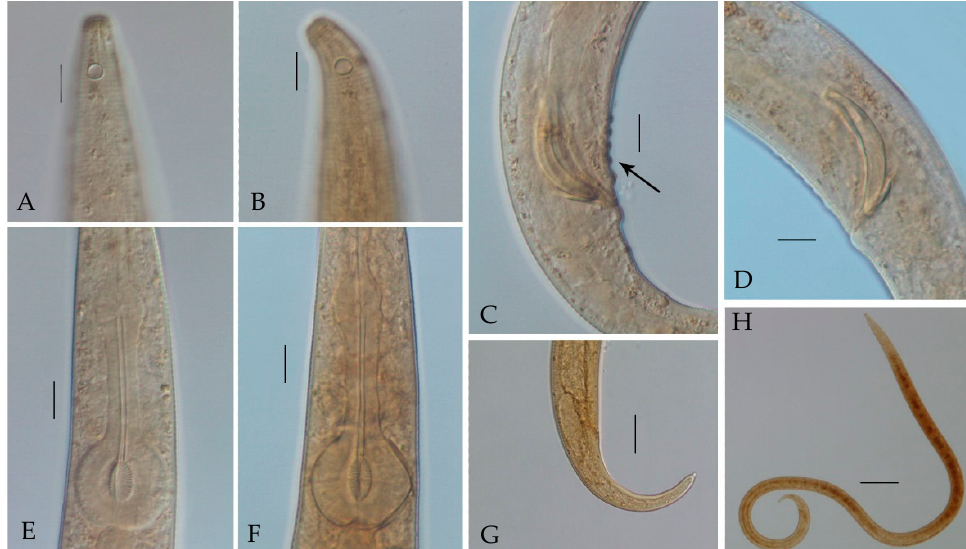
Figure 2. Haliplectus major sp. nov. ( A ) lateral view of male head end showing amphidial fovea; ( B ) lateral view of female head end showing amphidial fovea; ( C ) lateral view of male supplements; ( D ) lateral view of male copulatory apparatus; ( E ) lateral view of male pharynx basal bulb; ( F ) lateral view of female pharynx basal bulb; ( G ) lateral view of female tail region; ( H ) lateral view of male total body. Scale bars: ( A – F ) = 10 µm; ( G ) = 25 µm; ( H ) = 100 µm.